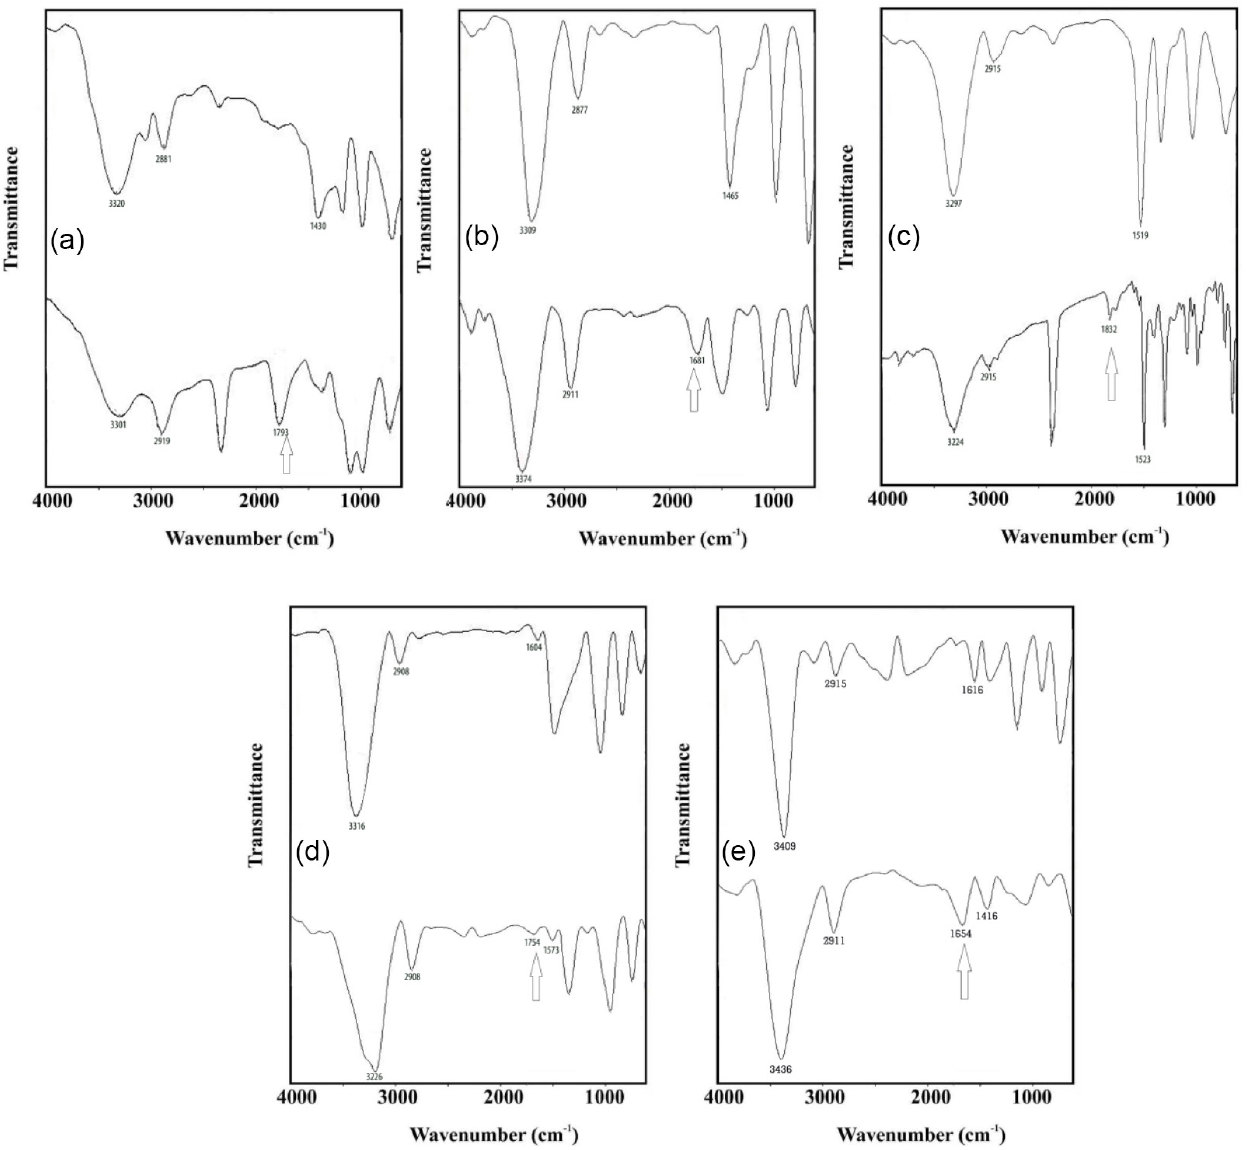
Fig. 7. FT-IR spectra of a) benzyl alcohol, b) 2-methyl benzyl alcohol, c) 2-nitro benzyl alcohol, d) 4-chloro-benzyl alcohol, and e) 4-hydroxy- benzyl alcohol and corresponding esteric products. In all figures the stretching vibrations of carbonyl groups (C=O) of corresponding products are shown with arrows.